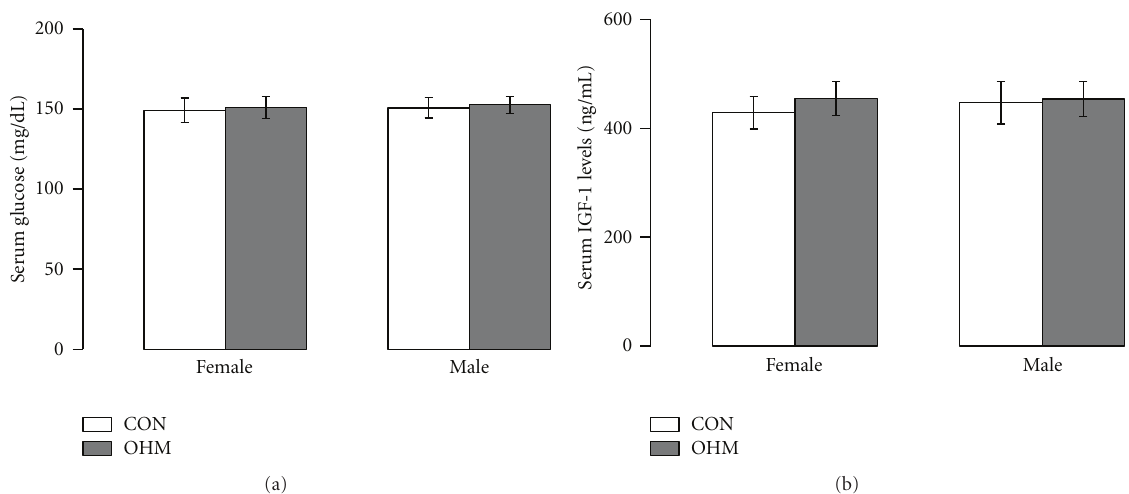
Figure 2: Maternal hyperglycemia did not decrease o ff spring glucose and serum IGF-1 levels . (a) DOL 21 OHM glucose levels for female and male o ff spring, CON in white bars and OHM in grey bars. (b) DOL 21 OHM serum IGF-1 levels for female and male o ff spring, CON in white bars and OHM in grey bars. Serum glucose and IGF-1 levels were expressed as mean ± standard error of the mean, n = 6 CON female, n = 6 OHM female, n = 6 CON male, and n = 6 OHM male.